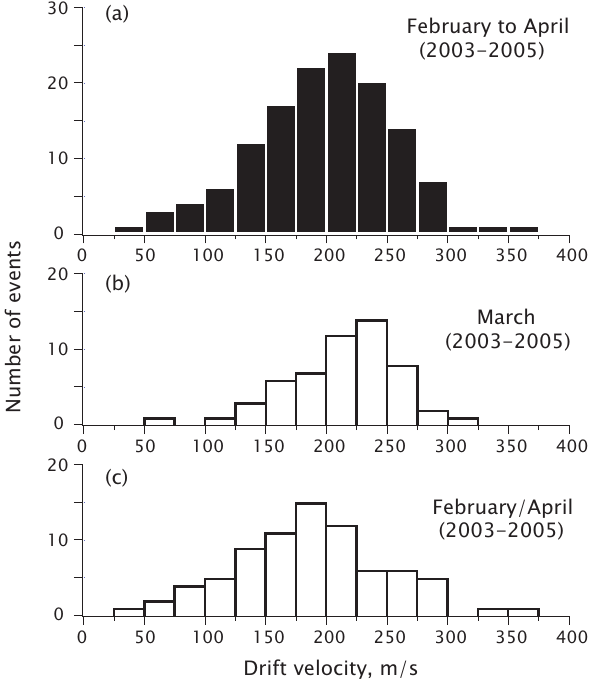
Fig. 9. Zonal drift velocity for (a) the February to April period from 2003 to 2005, (b) March (high occurrence month) only, and (c) February and